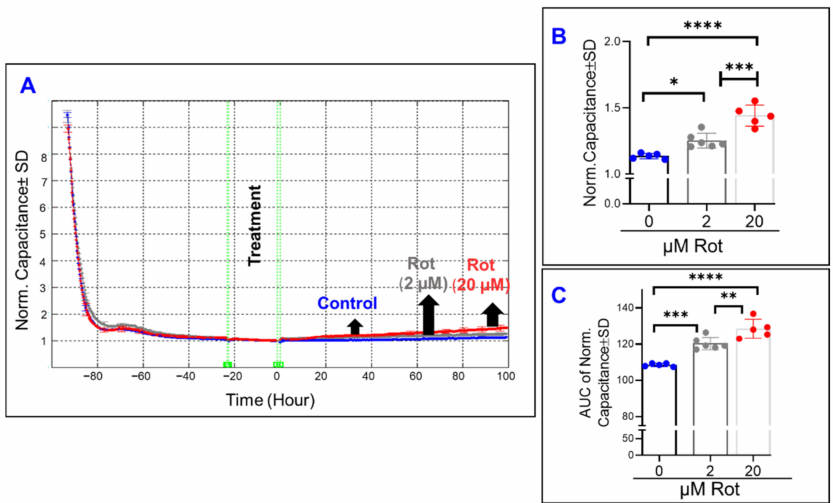
Figure 4. Real-time spreading of ARPE-19 cells under inhibition of complex I of the electron transport chain. ( A ) Normalized capacitance across ARPE-19 cells vs. time, measured at an AC current frequency of 64,000 Hz. Treatments were applied at time T = 0. ARPE-19 cell groups were the control, rotenone 2 µ M treatment, and rotenone 20 µ M treatment. Capacitance was measured from time of placement onto electrode to 100 h after treatment application, and capacitance values were normalized to that at T = 0. ( B ) Bar chart representation of the normalized capacitance of each of the cell groups at time T = 100 h, the experiment’s endpoint. ( C ) Bar chart representation of the area under the normalized capacitance curve of the ARPE-19 cell groups for the interval T = 0–100 h. Both doses of rotenone disrupted cell spreading during the experiment. Abbreviations: AUC, area under the curve. Data shown are the mean ± SD of 5–6 independent biological replicates per group. p values are * p ≤ 0.05, ** p ≤ 0.01, *** p ≤ 0.001, and **** p ≤